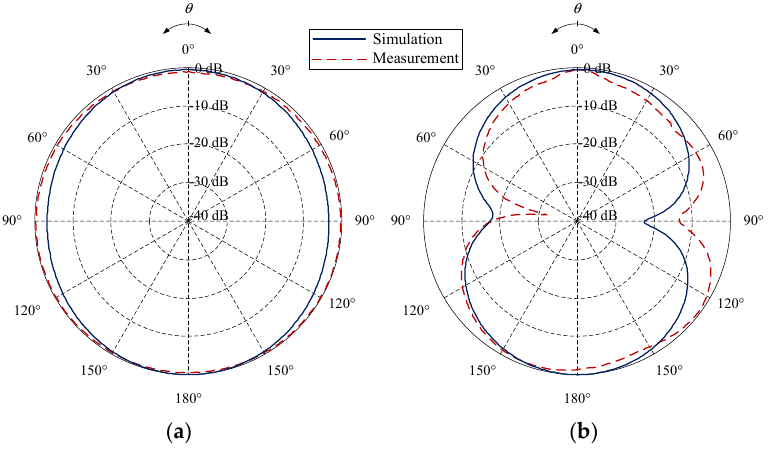
Figure 11. Simulated and measured radiation pattern at 2.45 GHz: ( a ) xz -plane and ( b ) yz -plane.